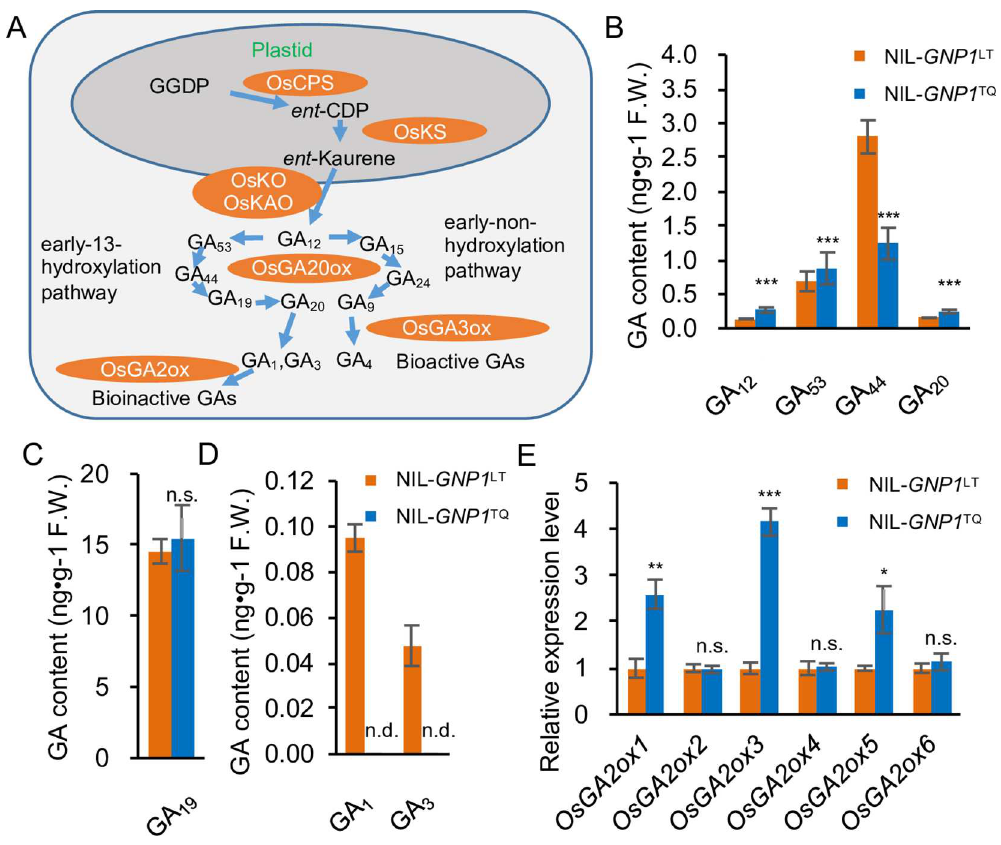
Fig 5. The differences between GNP1 TQ and GNP1 LT alleles affect GA biosynthesis. (A) General overview of GA metabolism pathway in higher plants accordingto previous reports. (B–D) Comparison of the contents of five GA biosynthesis intermediates in the early-13-hydroxylationpathway and two bioactive GAs between young NIL- GNP1 LT and NIL- GNP1 TQ panicles(~1 cm) at early panicleinitiationto booting stage. Values are means ± s.d. (n = 4, each with 6 plants); n.d., not detected (levels are far too low that beyond the accuracy of detection method). Orange columns, NIL- GNP1 LT ; blue columns, NIL- GNP1 TQ . (E) Relativeexpressionlevels of rice GA catabolism- related genes in young NIL- GNP1 LT and NIL- GNP1 TQ panicles(~1 cm) at early panicle initiationto booting stage. Values are means ± s.d. (n = 4, each with 6 plants). Asterisks represent significant difference determined by Student’s t-test at p -value < 0.001 ( *** ), p -value < 0.01 ( ** ), p -value < 0.05 ( * ), not significant